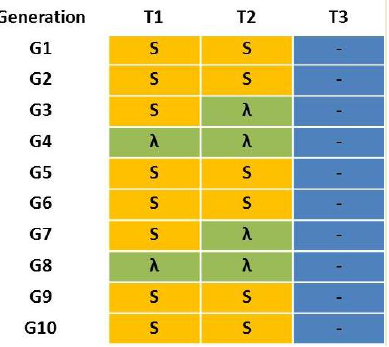
Figure 1. Treatment scenarios T1–T3 for the multi-resistant MR laboratory strain of Ceratitis capitata . “S” in yellow means a treatment with 100 ppm of spinosad, “λ” in green means a treatment with 125 ppm of lambda-cyhalothrin and “-” in blue means absence of insecticide treatment.